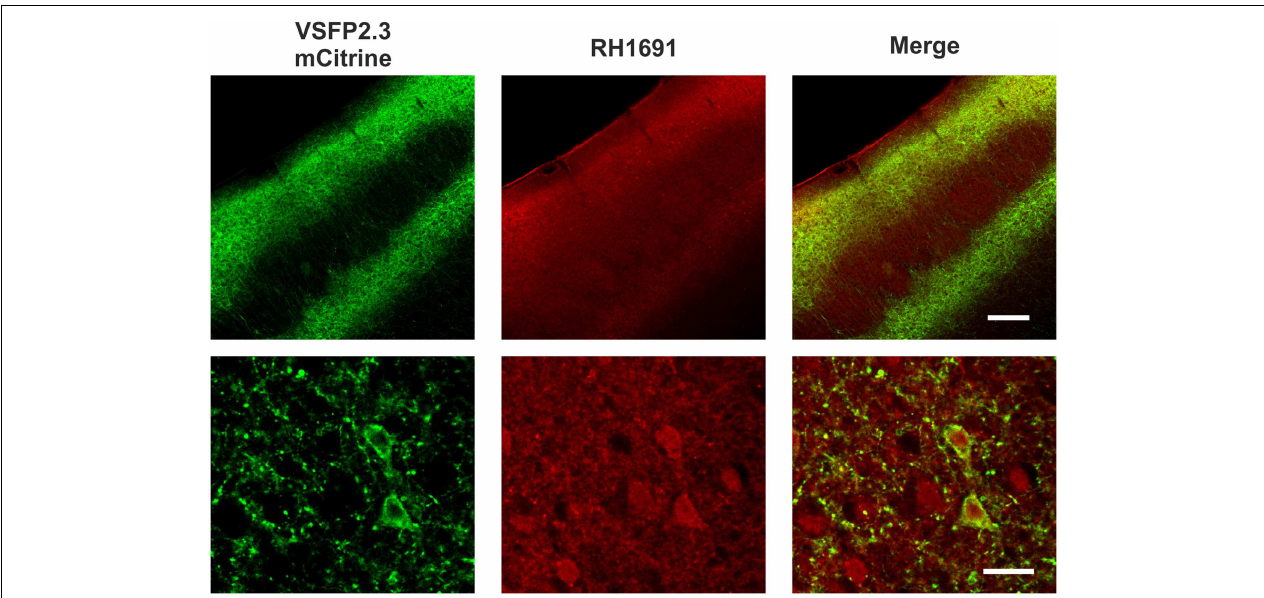
FIGURE 4 | Distribution of VSFP2.3 and RH1691 fluorescence of fixed coronal sections of the somatosensory cortex. VSFP2.3 Citrine fluorescence (left column) and RH1691 fluorescence (middle column) and merged image (right column). Upper row low magnification (scale bar,